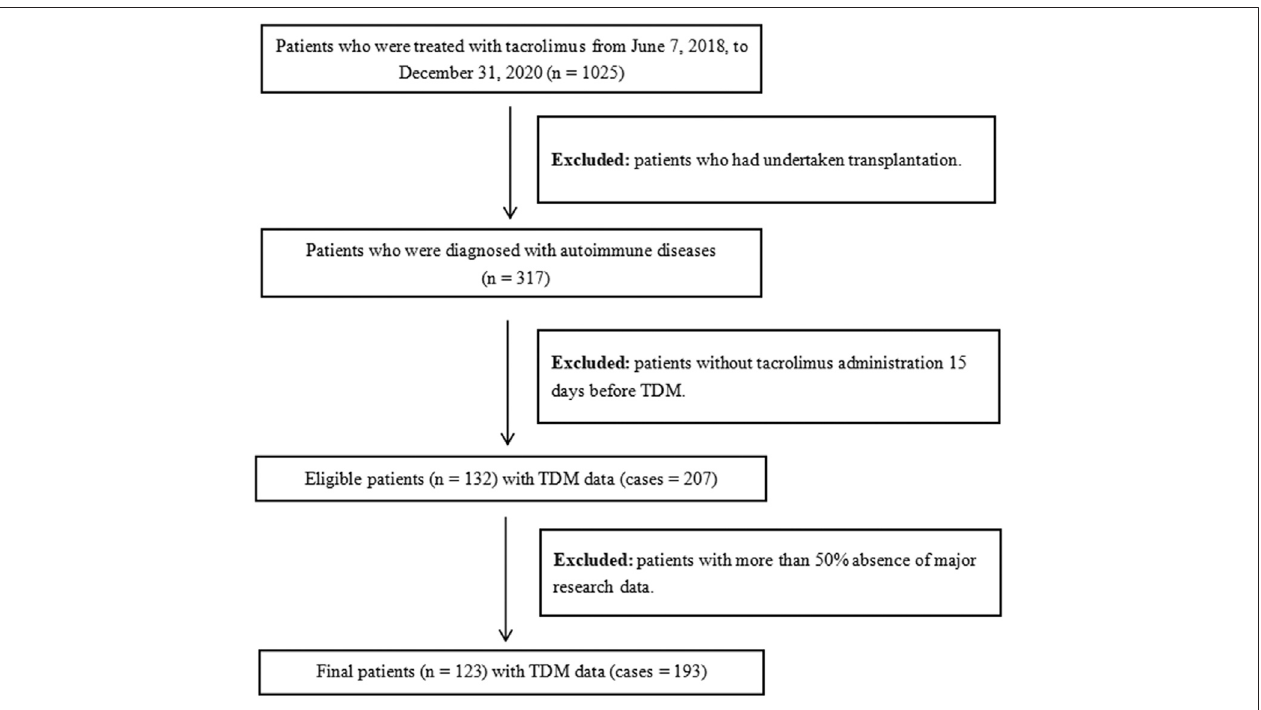
FIGURE 1 | Work fl ow of patients